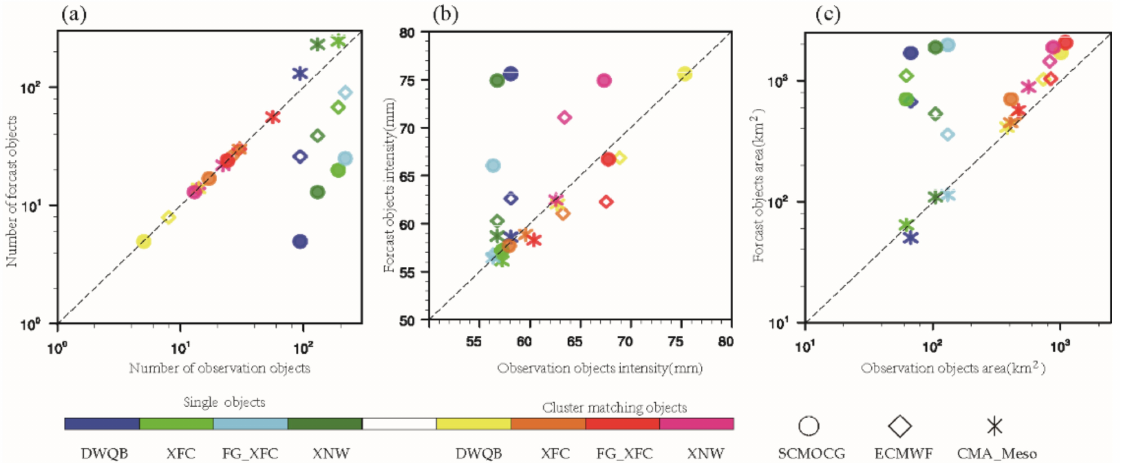
Figure 6. Comparison of the number, intensity, and area of the matched cluster of objects verified by the MODE method of the three precipitation forecast products under different circulation situations. Warm color signifies the cluster object, and cold color signifies a single independent object. The dot represents SCMOC, the star represents CMA-Meso, and the diamond represents ECMWF. ( a ) Number. ( b ) Intensity. ( c )